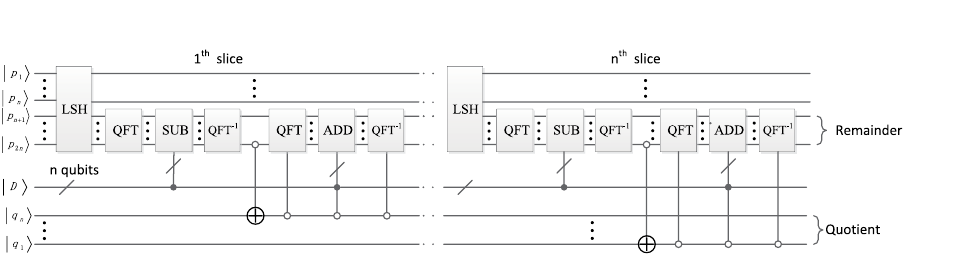
Figure 19. An example of 4 × 4 PM, where PS 0 and PS 1 represent the partial sums of P 0 , P 1 , P 2 , P 3 .